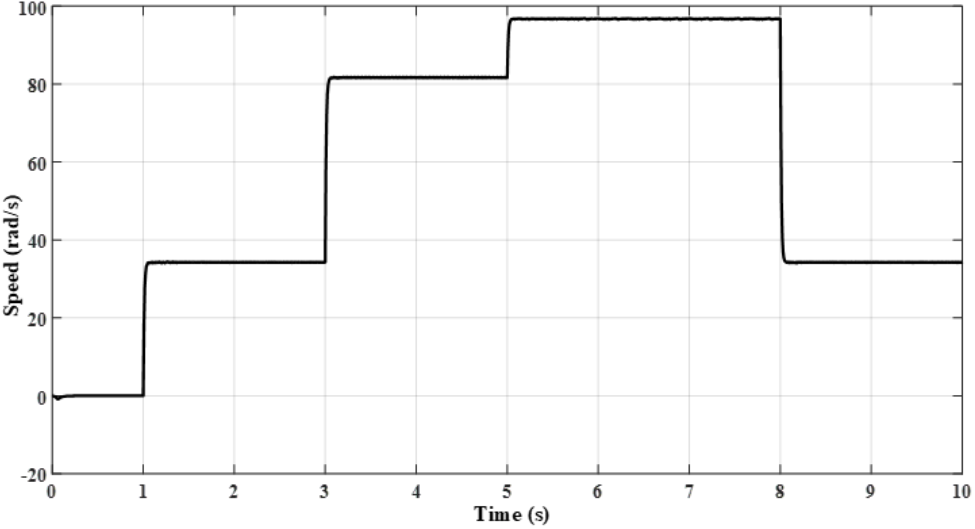
Figure 14. The DTRFC with successive steps of torque reference for speed